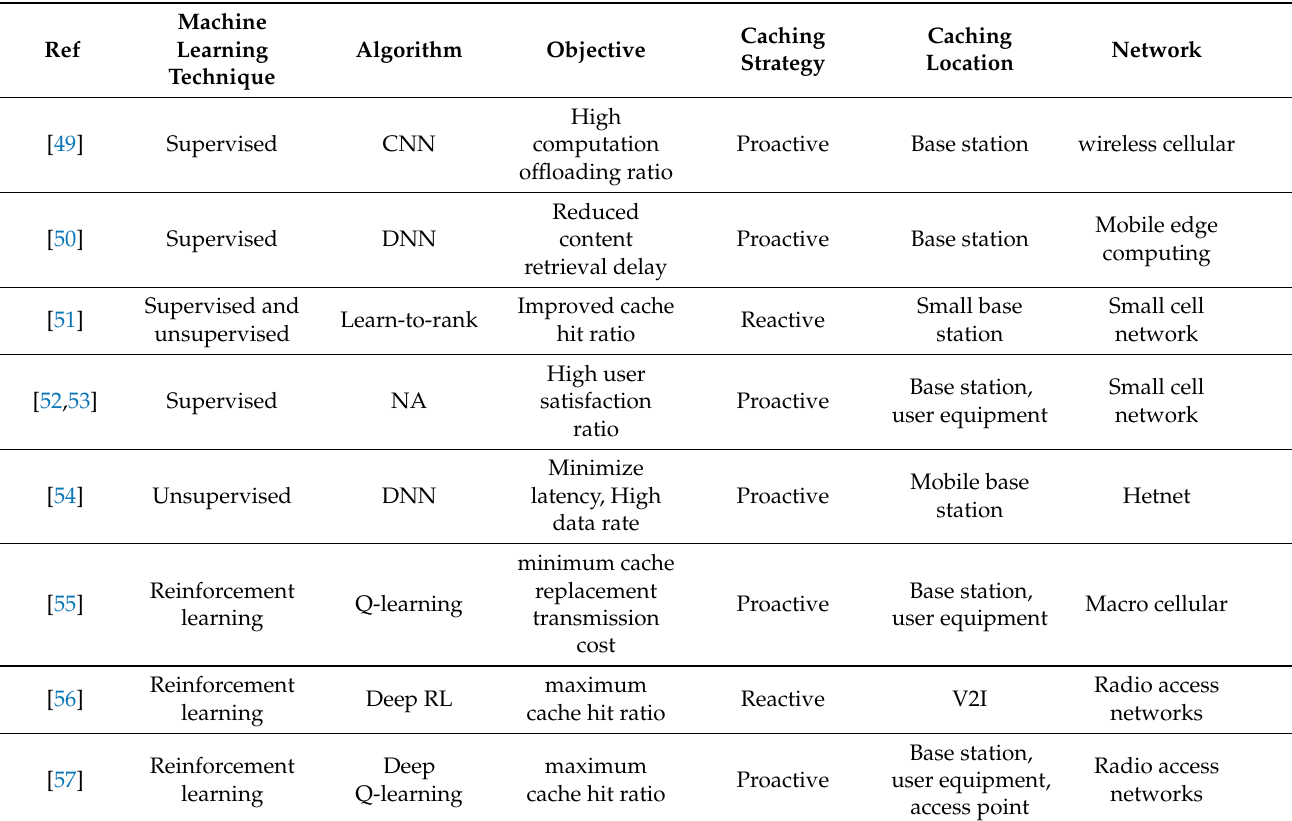
Table 1. AI-based caching